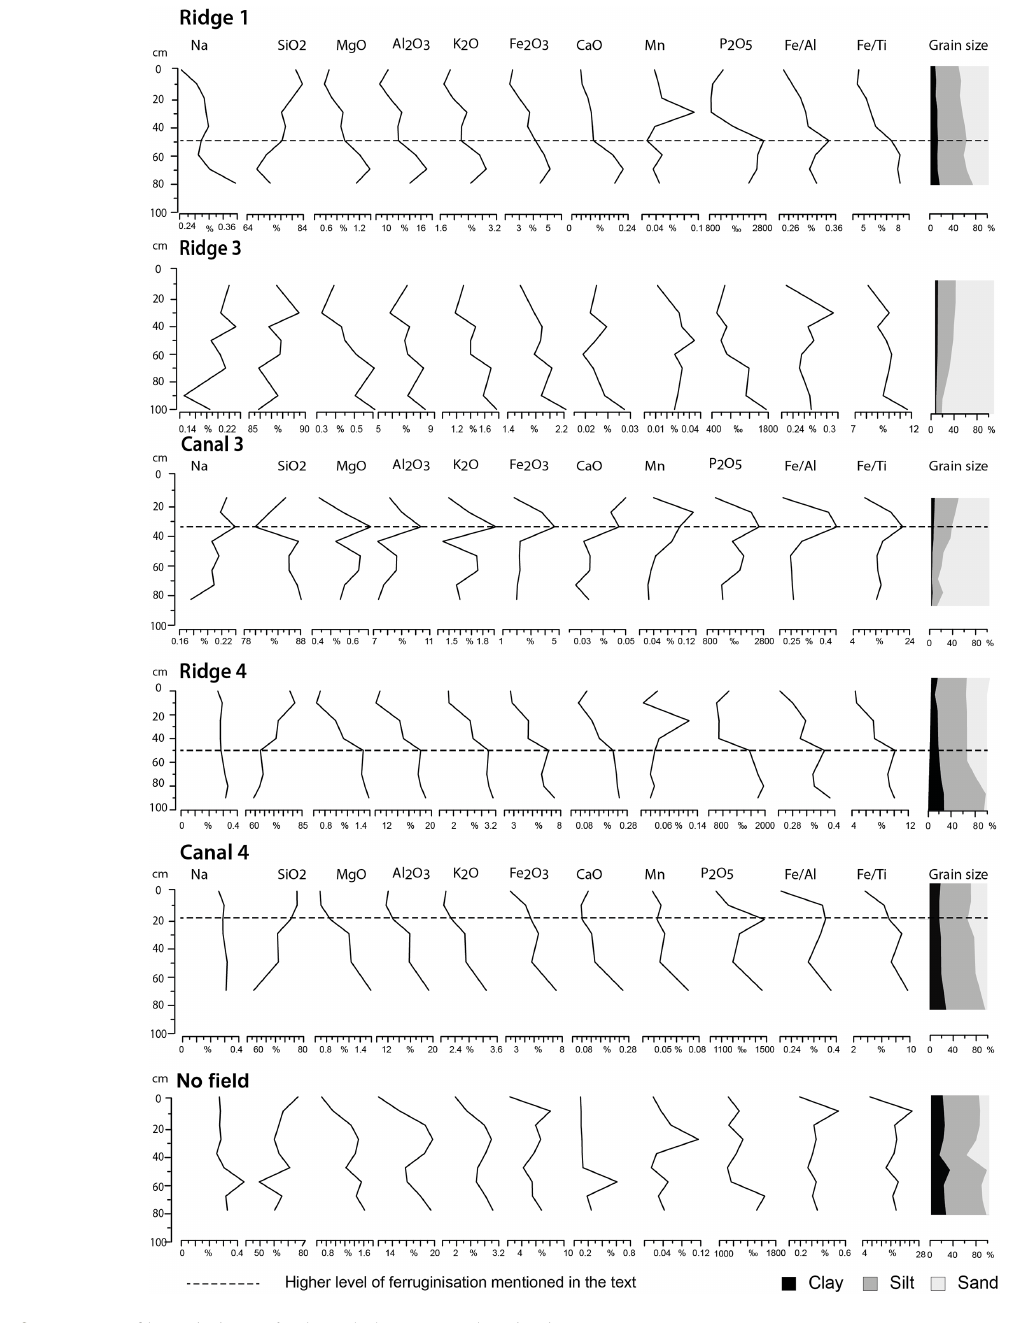
Figure 6. Down-profile variations of selected elements and grain size.